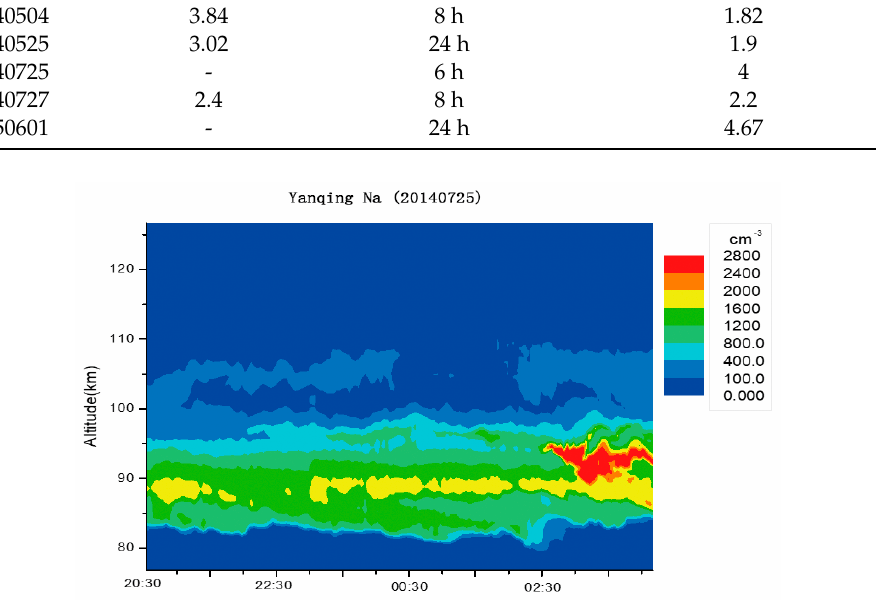
Figure 9. The tidal phase speed versus the speed of the descending LTSL (“ − km/h”: negative means downward).